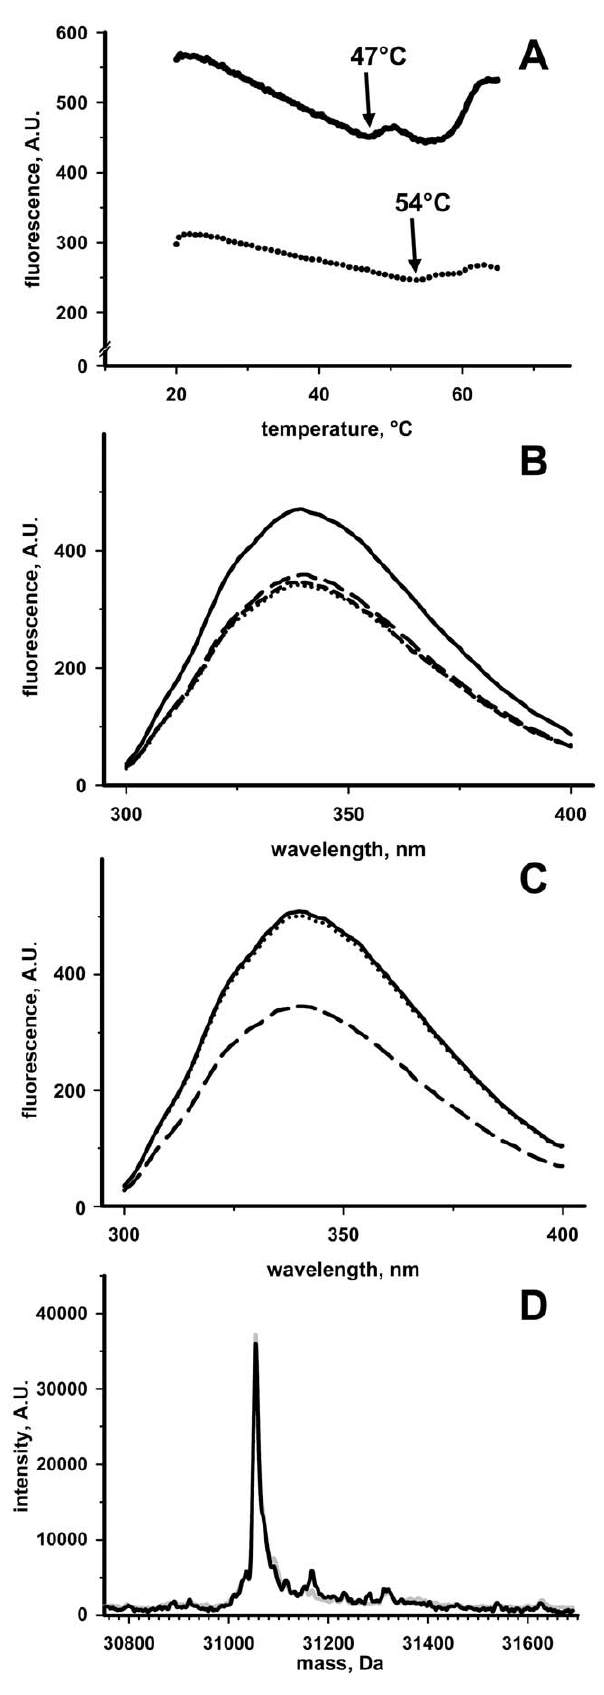
Figure 5. Analyses of the RhdA/GSH interaction. ( A ) Thermally- induced fluorescence changes of 2 m M RhdA (solid line) and RhdA/GSH complex (dotted line) in 50 mM Tris-HCl, 100 mM NaCl (pH 7.4). Tryptophan fluorescence was monitored as a function of the indicated temperature. Transition temperatures of the first conformational change are indicated. ( B ) Tryptophan fluorescence emission spectra ( l ex =280 nm) of 2 m M RhdA/GSH complex alone (dotted line) in 50 mM Tris-HCl, 100 mM NaCl (pH 7.4), in the presence of 0.8 mM Tris(2-carboxyethyl)phosphine (TCEP; long-dashed line), and in the presence of 0.2 mM DTT (short-dashed line). For RhdA/GSH complex preparation, RhdA was treated with GSH and unbound GSH was removed by gel-filtration. Solid line reports the spectrum of 2 m M RhdA alone. ( C ) Tryptophan fluorescence emission spectra ( l ex =280 nm) of 2 m M RhdA alone in high-saline concentrated buffer (50 mM Tris-HCl, 1 M NaCl) (solid line) and in the presence of 0.25 mM GSH (dotted line). Spectrum of 2 m M RhdA in the presence 0.25 mM thiosulfate is reported as a positive control (dashed line). ( D ) LC/ESI Q-ToF analysis of RhdA/GSH complex prepared by 20 min incubation (25 u C) of RhdA with 8-fold molar excess GSH, followed by desalting on C4-chromatographic pipet tip. Molecular mass range of the deconvoluted ESI spectra of RhdA (grey line) and RhdA/GSH complex (black line) is